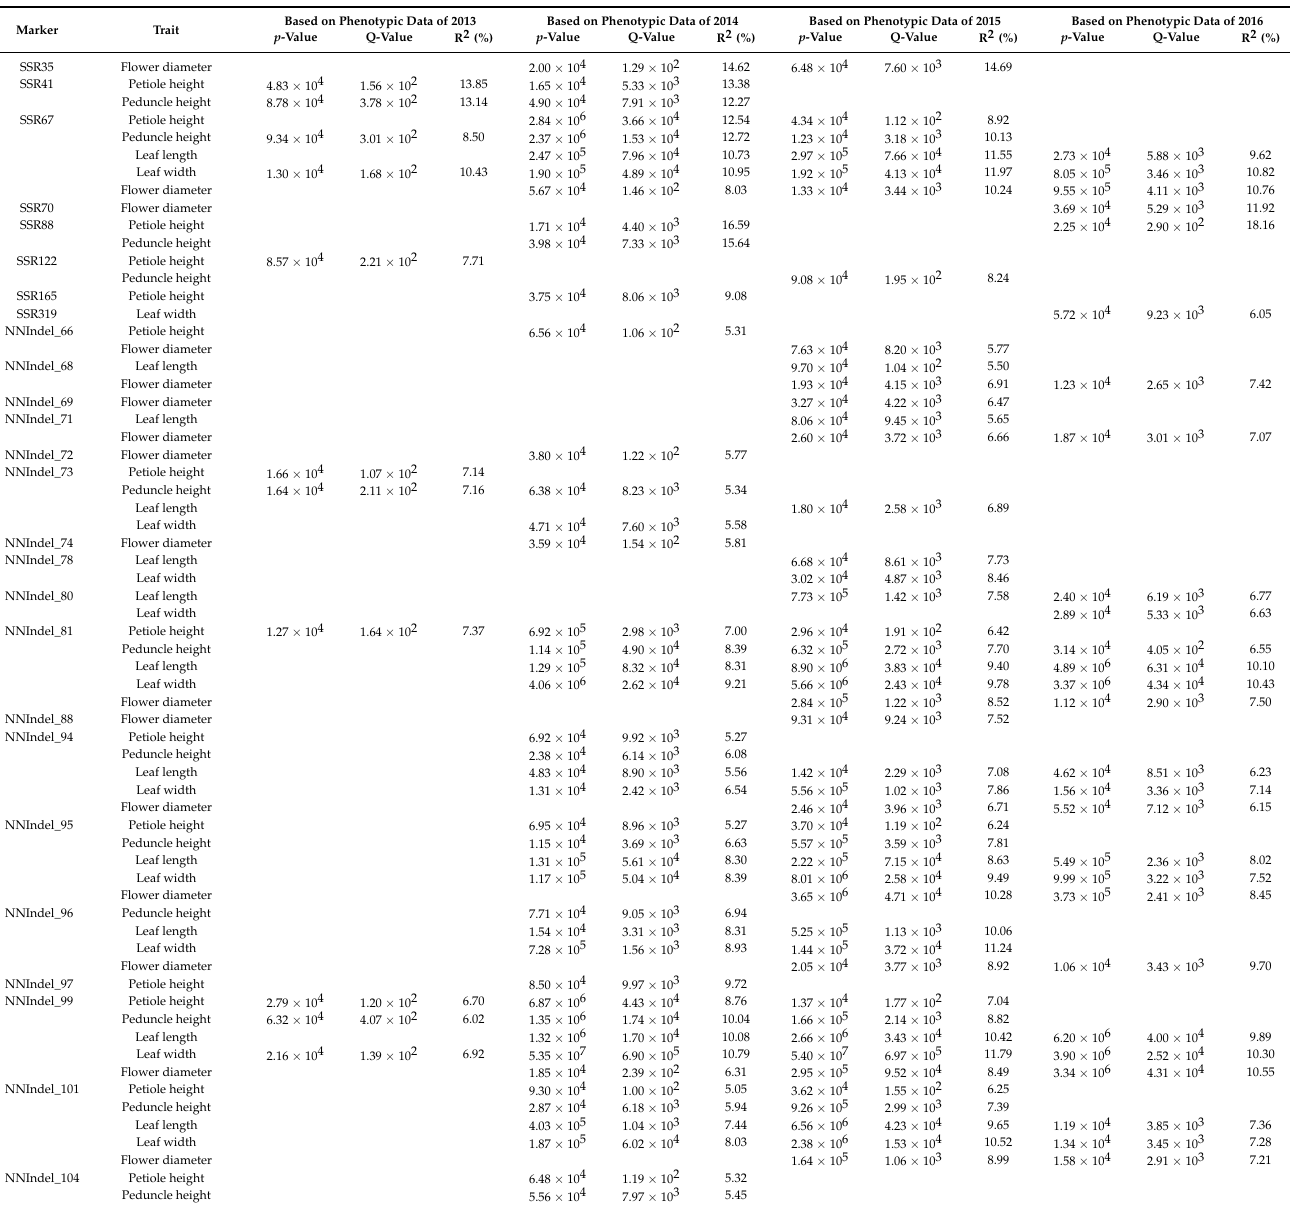
Table 2. The SSR and InDel markers significantly associated with the PA-related